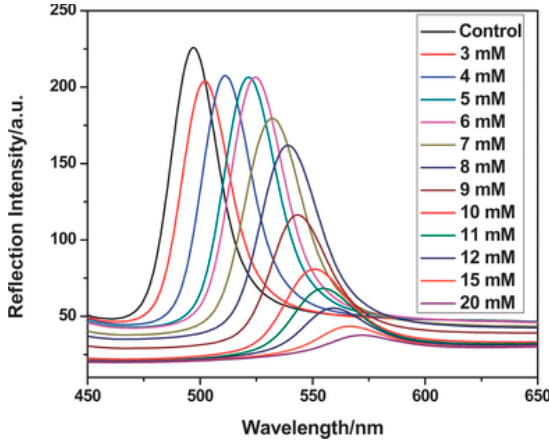
Figure 2. Optical responses of PNA OCP PC to different glucose concentrations. Note: